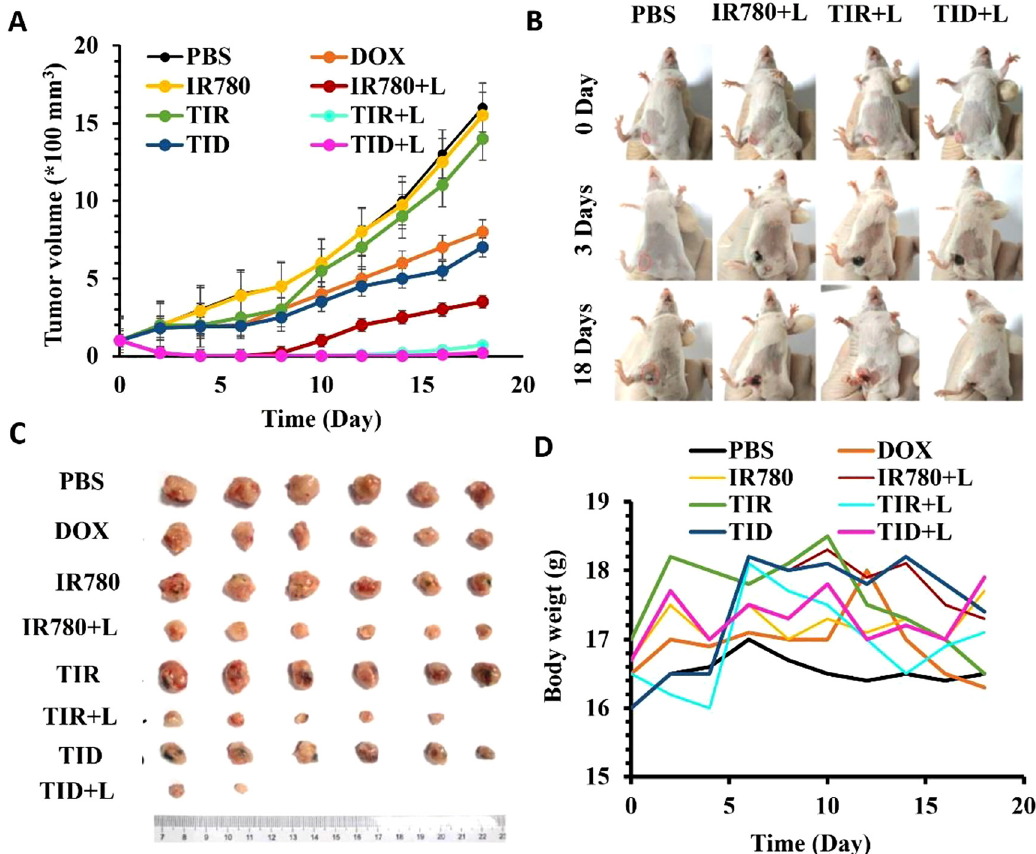
Figure34: SynergisticantitumoreffectsofTIDNPs-mediatedtrimodaltreatmentofnucleus-targetedPTT/PDTandchemotherapyin4T1tumor- bearing mice. (A) Tumor growth curves of the mice treated with free Dox, free IR780, TIR, and TID NPs combined with ( + L) and without laser irradiation. (B) Photos of the mice at 0-, 3-, and 18-days post-treatment with free IR780, TIR, and TID NPs combined with laser irradiation ( + L). Red cycles indicate the recurrent tumors. (C) Photo of the tumors derived from the mice at the end of various treatments (D) Body weight changes of the mice with various